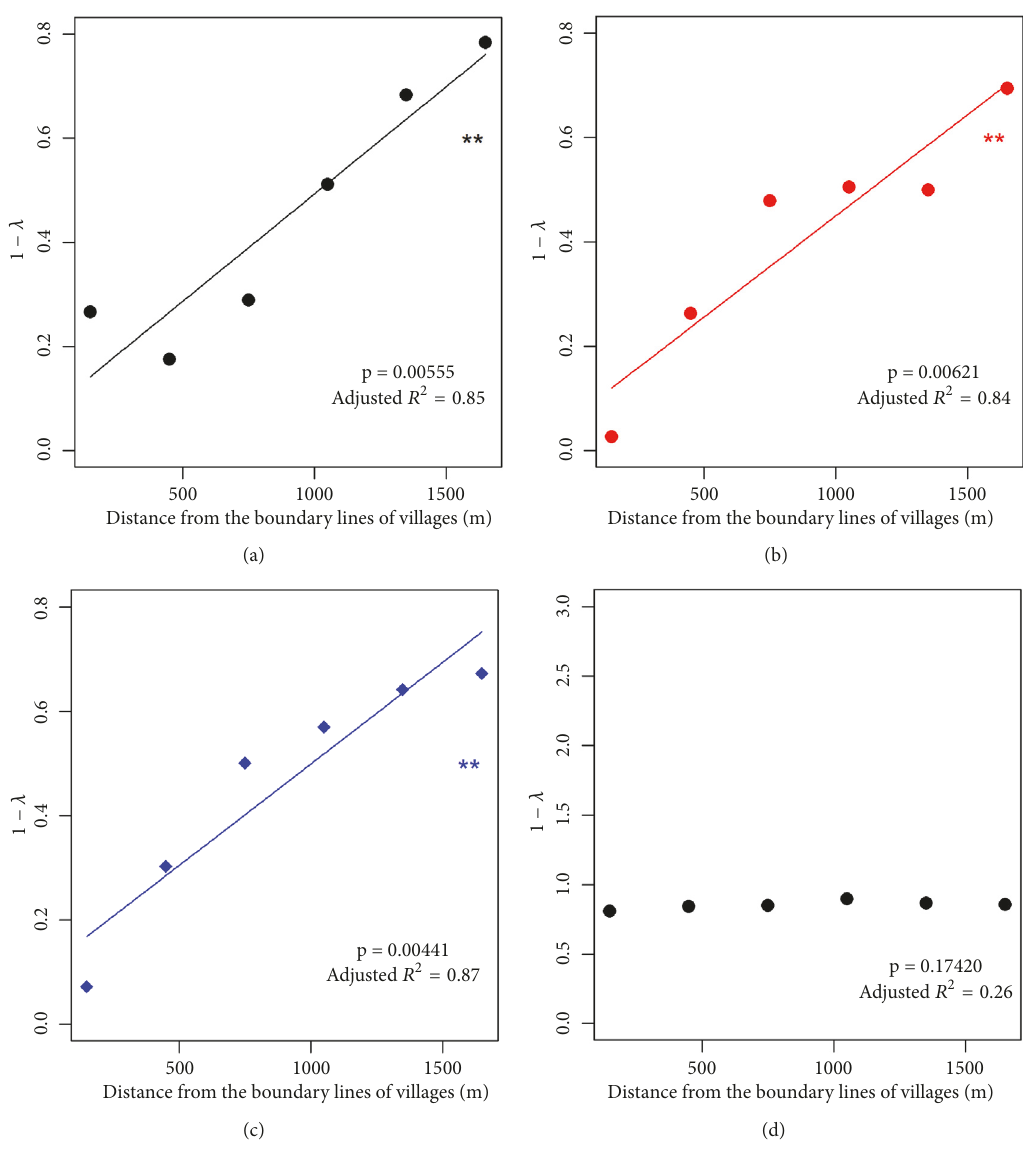
Figure 10: 1 – Simpson’s 𝜆 (1 - ∑ pi 2 ) plotted against the distance from the village boundaries. (a) Janajagaran Forest: significant (p < 0.01), (b) Musharni Mai Forest: significant (p < 0.01), (c) Radha Krishna Forest: significant (p < 0.01), and (d) Parsa Wildlife Reserve: nonsignificant (p > 0.05).